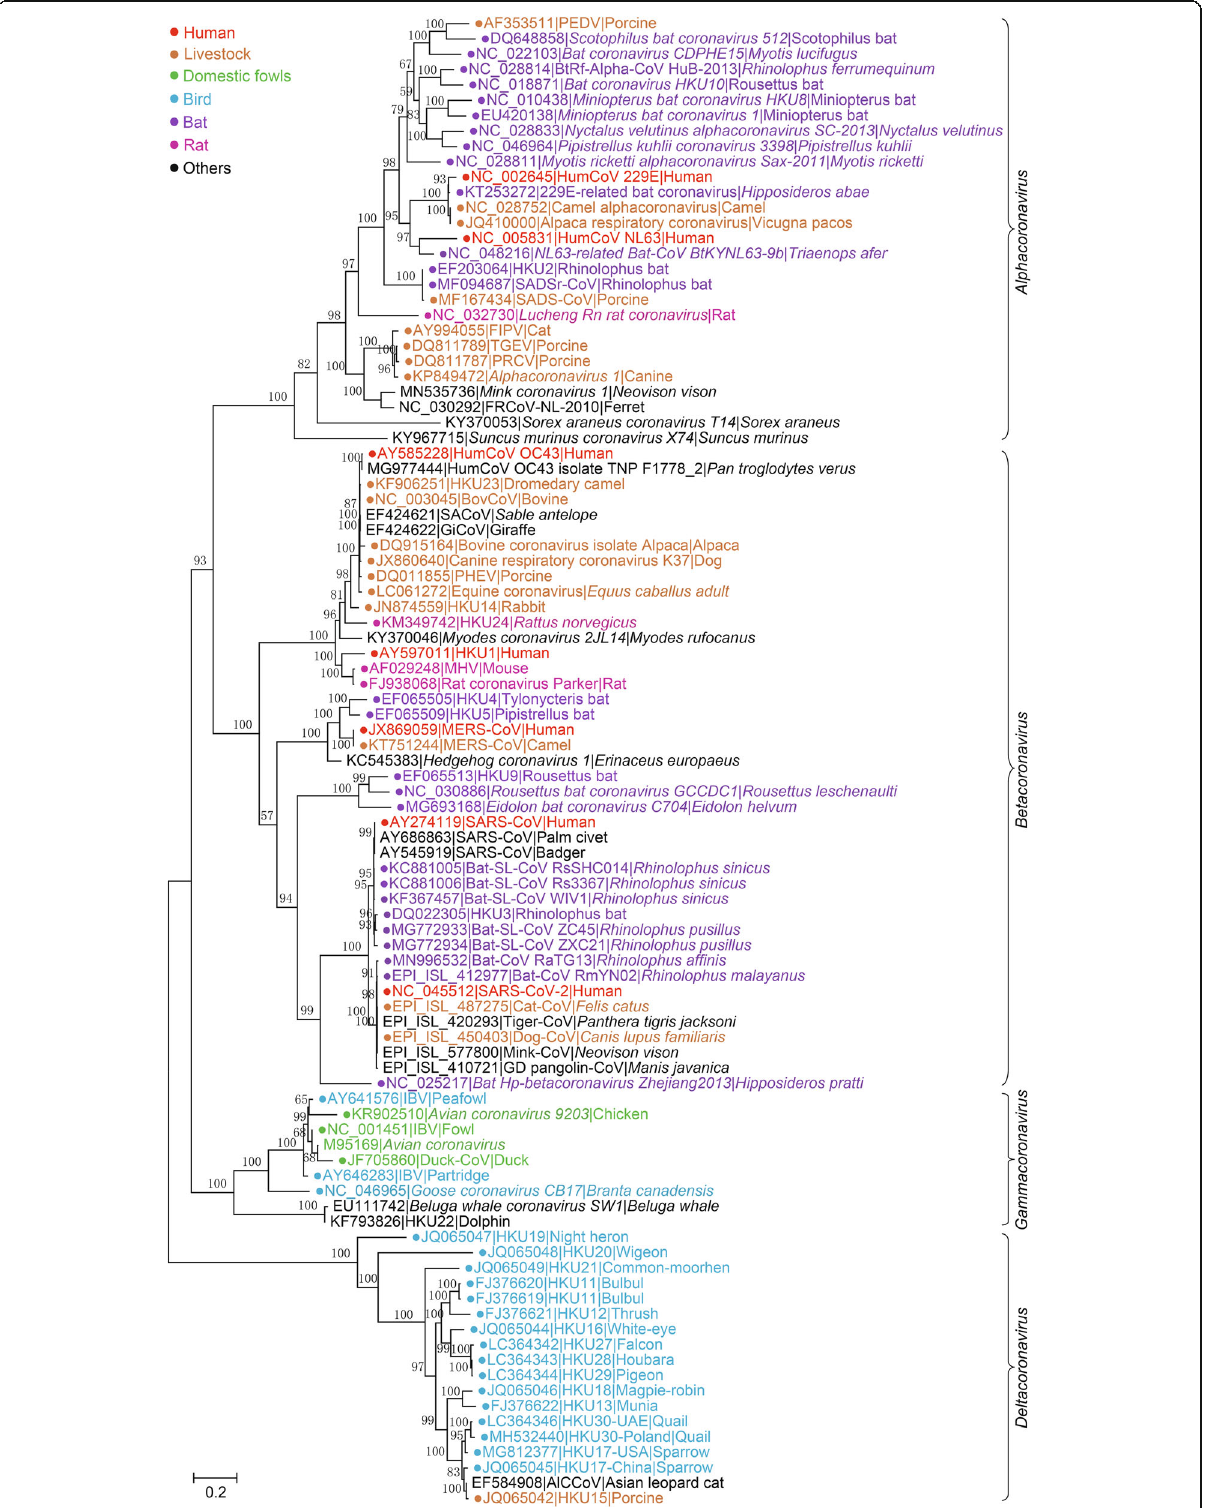
Fig. 3 The maximum likelihood tree of coronaviruses based on amino acid sequences of RdRp gene. The tree was constructed using an IQ-tree with 10,000 ultrafast bootstraps and the most appropriate substitution model of LG+F+I+G4, which was calculated by